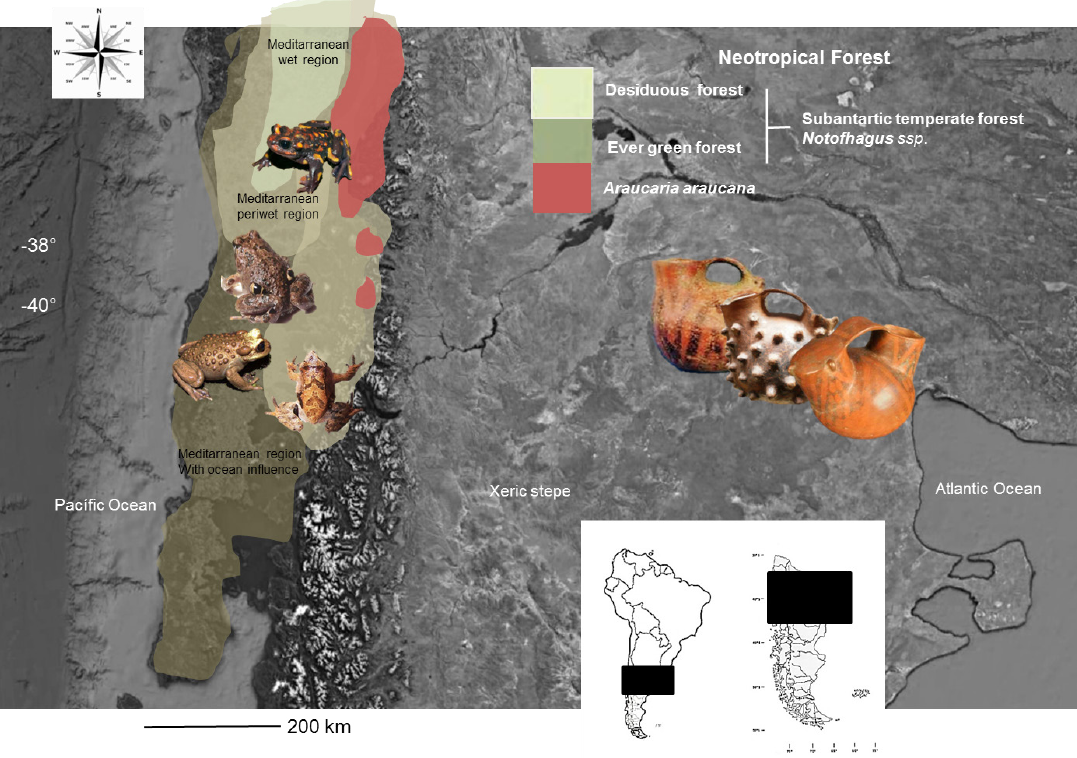
Figure 2. Habitat of species represented and distribution of black over red